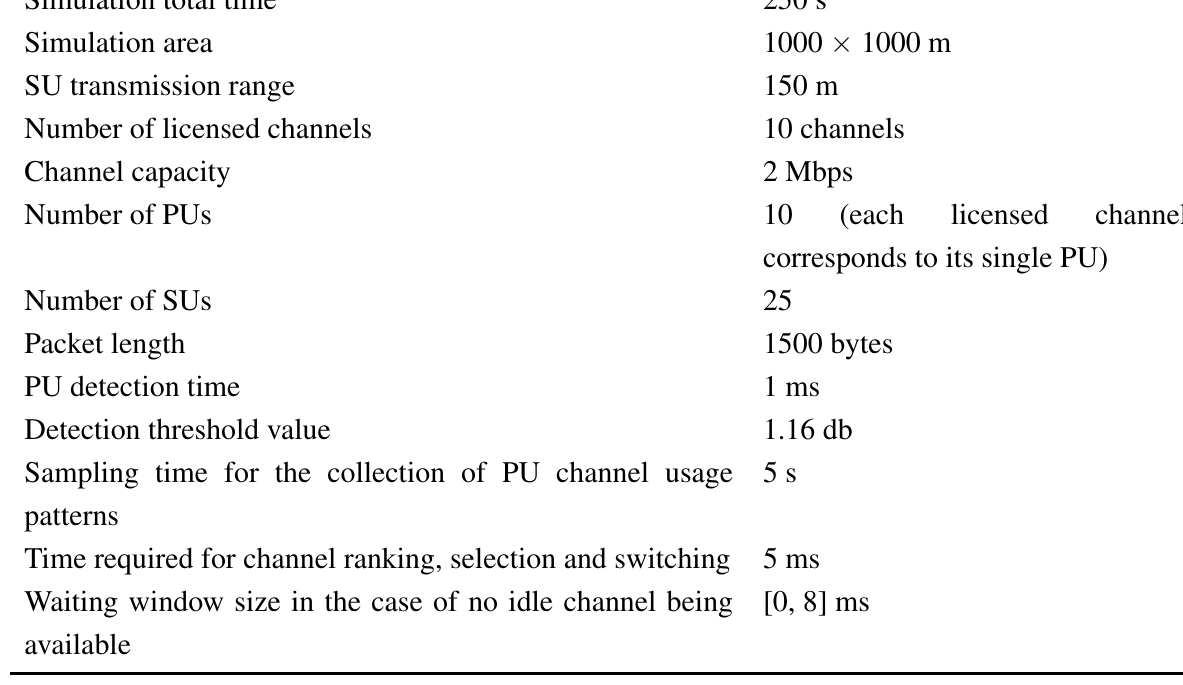
Table 2. Simulation